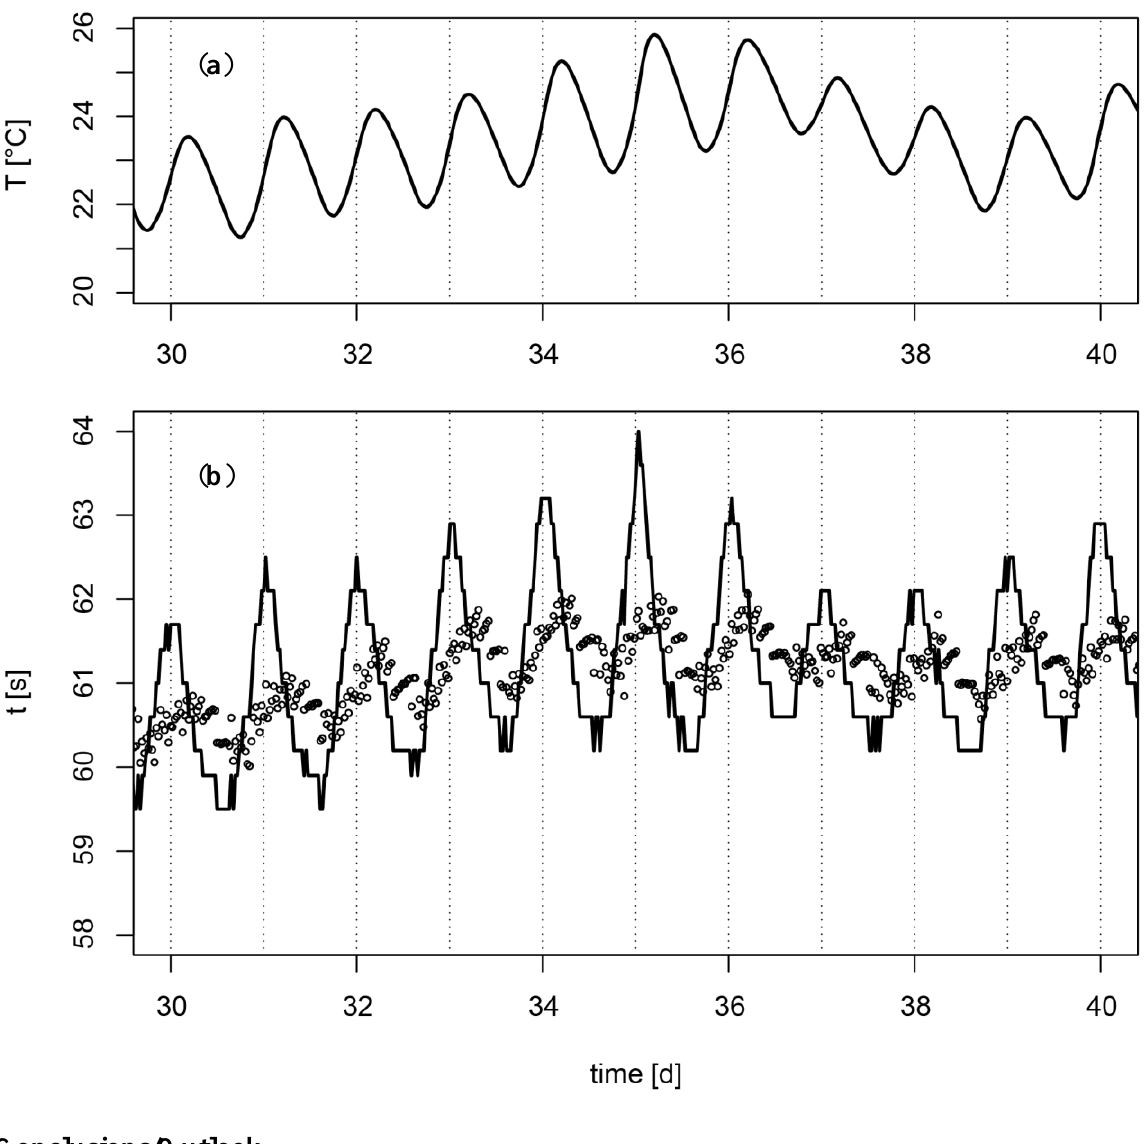
Figure 6. ( a ) Variations of soil temperature T (top) and ( b ) cooling time t ; uncorrected (solid line) and corrected for temperature changes (circles). The sensors were placed in an irrigated apple plantation in a depth of 25